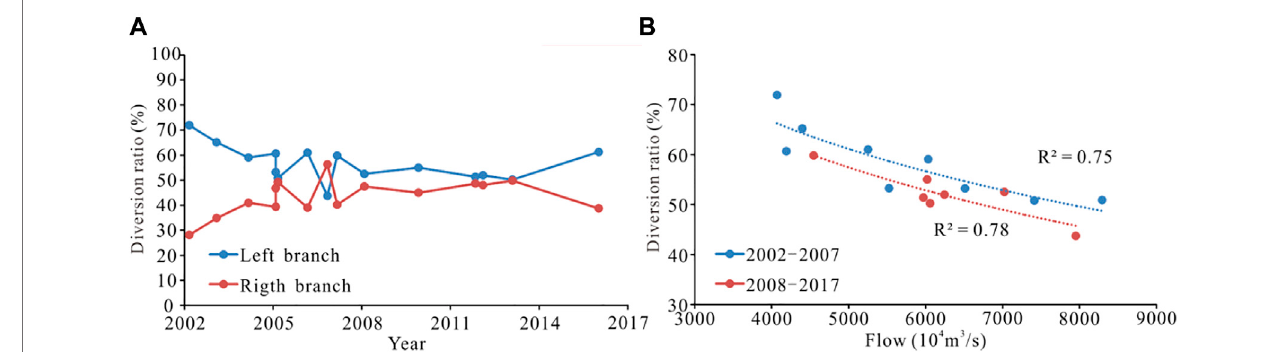
Frontiers in Earth Science |